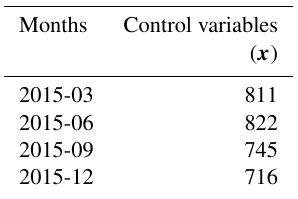
Table 1. Number of eigenvectors included in our control vector ( x ). Date format is